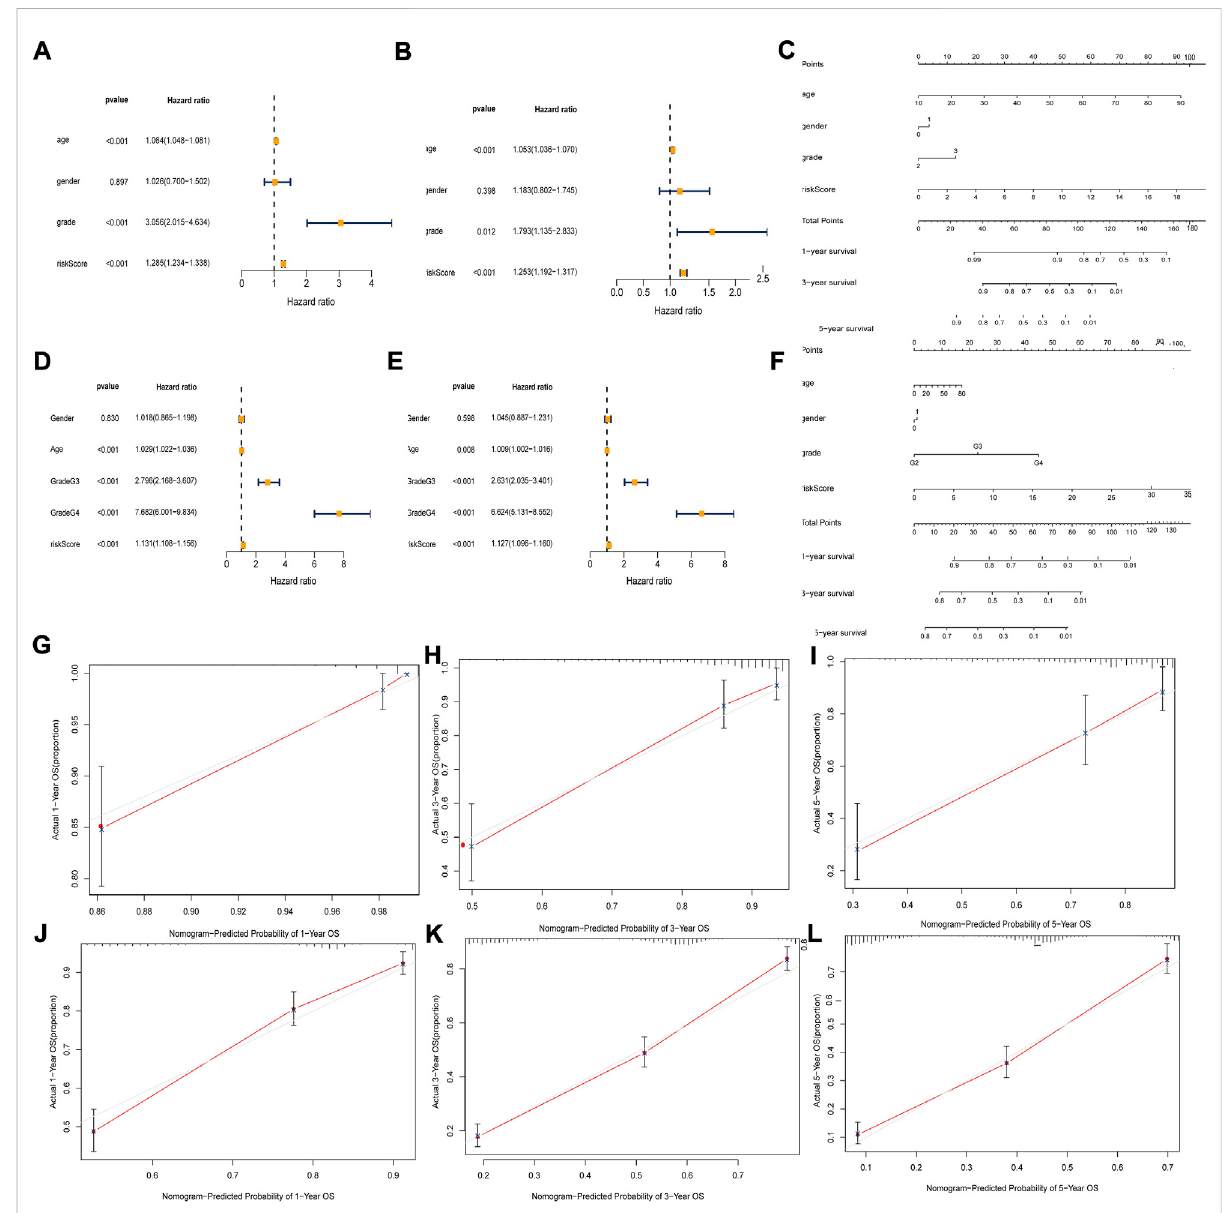
FIGURE 5 Independent prognosis analysis of risk score. (A and D) Univariate COX Forest plot of the risk score in TCGA and CGGA. (B and E) Multivariate COX Forest plotof therisk score in TCGA and CGGA. (Cand F) Nomogram basedon prognostic features in TCGA and CGGA. (G – I) Calibration plots of the nomogram for predicting the probability of OS at 1, 3, and 5 years in the TCGA. (J – L) Calibration plots of the nomogram for predicting the probability of OS at 1, 3, and 5 years in the